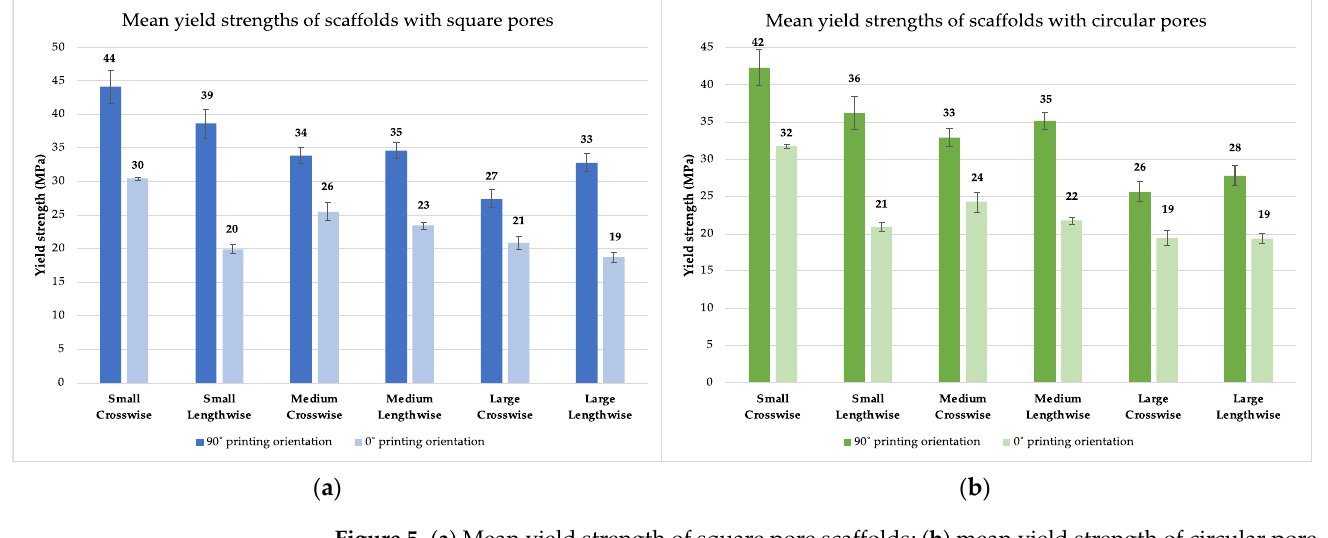
Figure 5. ( a ) Mean yield strength of square pore scaffolds; ( b ) mean yield strength of circular pore scaffolds. Error bars represent ± standard deviation, n = 5.